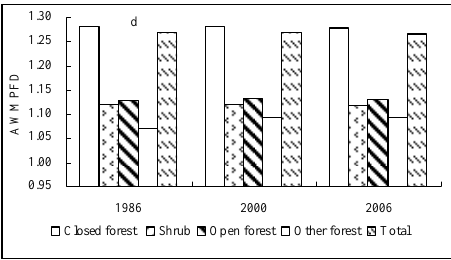
Figure 3. Landscape metrics of forest